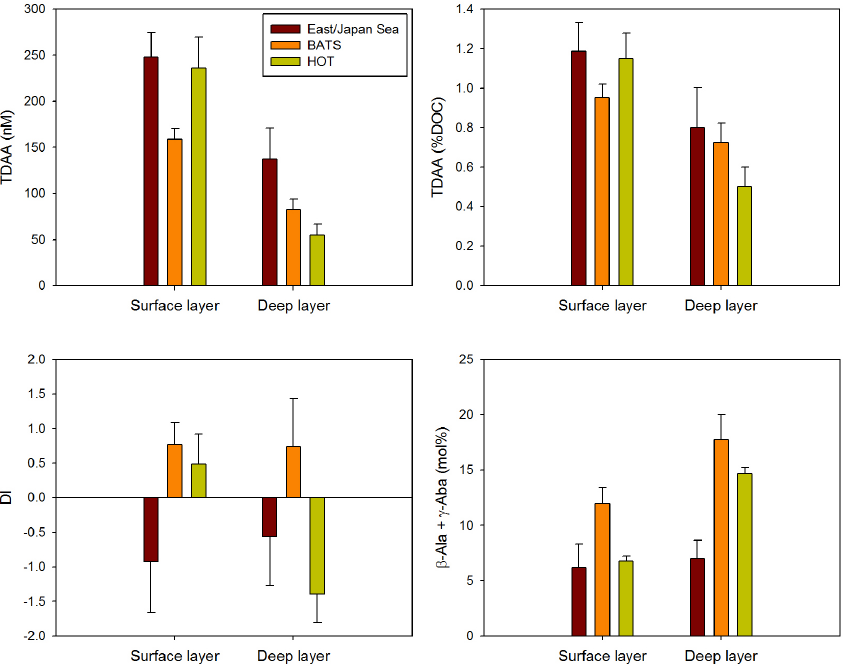
Figure 4. Average total dissolved amino acid (TDAA) concentrations, DOC-normalized yields of TDAAs (%DOC), degradation index, and mole percentage (mol%) of β -Ala + γ -Aba from surface (0–200m) and deep ( ≥ 1000m) layers in the East/Japan Sea, BATS, and HOT. Error bars represent standard